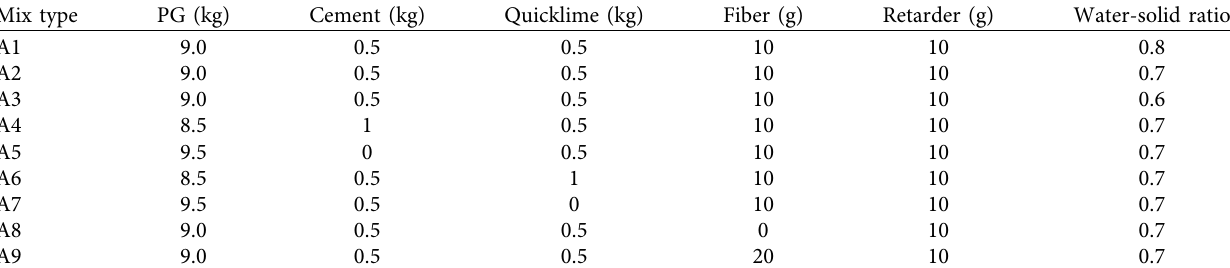
Table 2: Mix proportion of